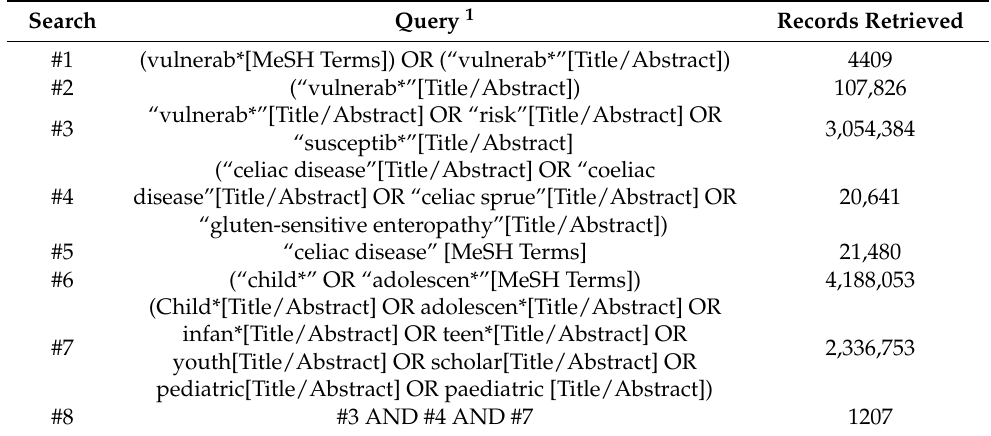
Table 1. Search strategy used in one of the databases—MEDLINE (via